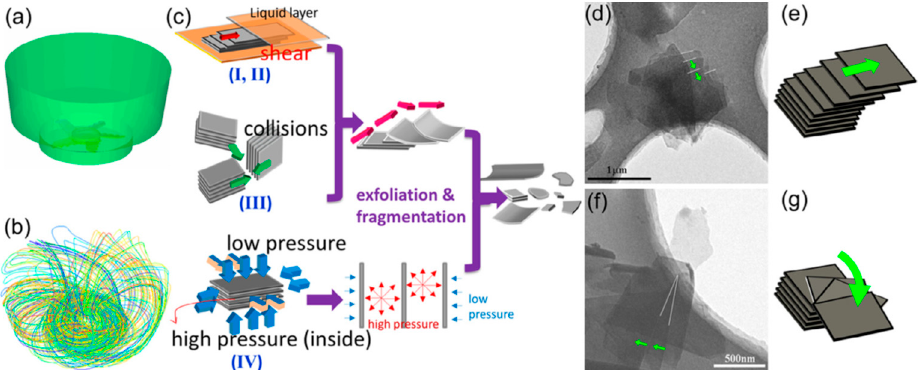
Figure 33. ( a ) Schematic of the simplified model used for computational fluid dynamics analyses. ( b ) Pathlines released form the impeller surface colored by particle ID. ( c ) Illustration for the exfoliation mechanism. Deliberately captured partially exfoliated FLG flakes with translational ( d , e ) and rotational ( f , g ) lateral exfoliation. Reproduced from [127]. Copyright Elsevier, 2014.